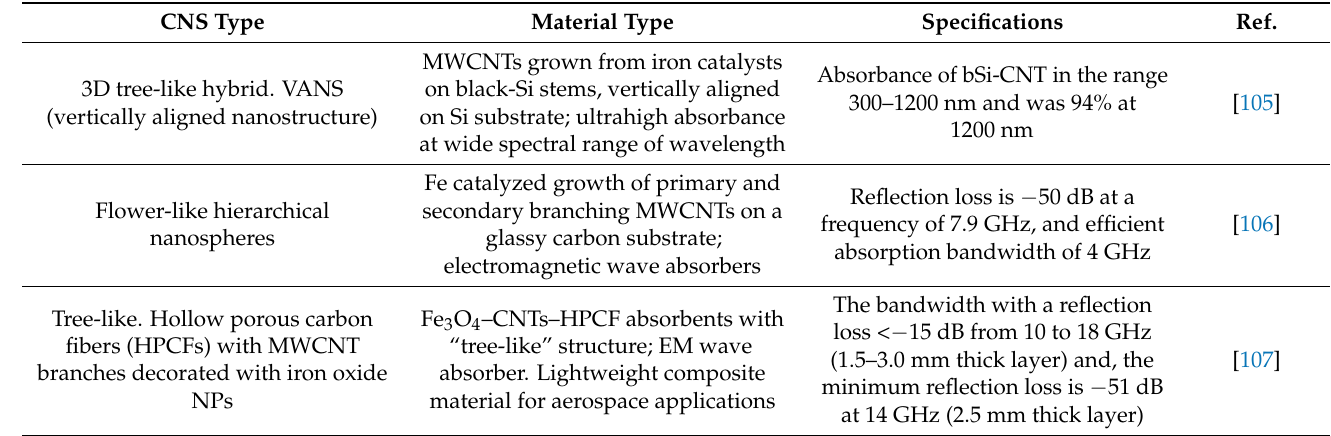
Table 4. Examples of branched CNSs used in EMW